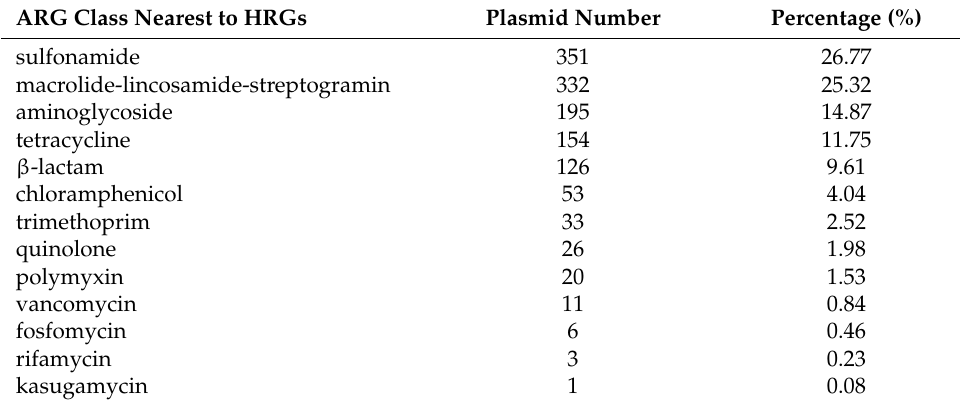
Table 3. Preferences of HRGs for various ARG classes (excluding multidrug resistant genes) in plasmid